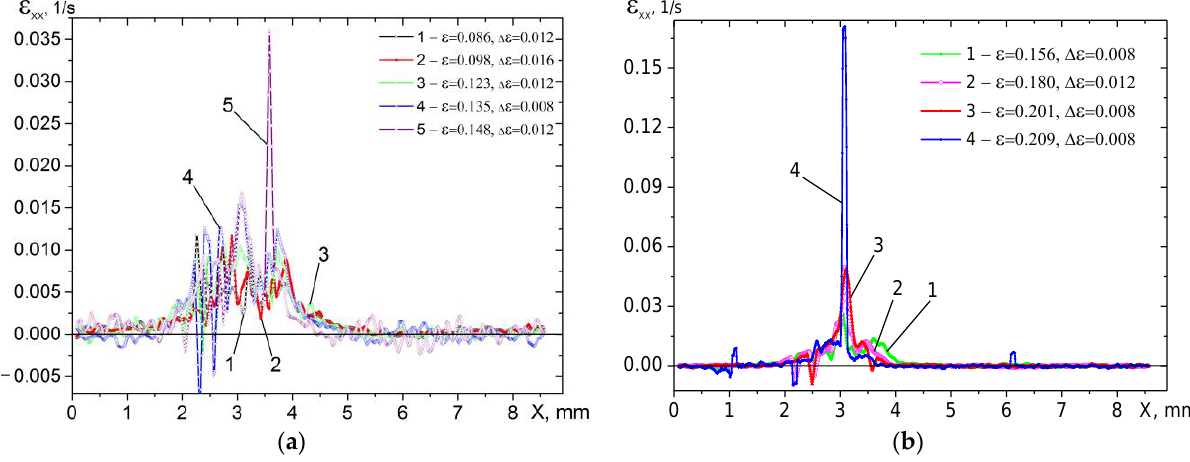
Figure 11. Spatial distribution of longitudinal strain ε xx ( x , y = y m /2 ) at the second ( a ) and third ( b ) stages.